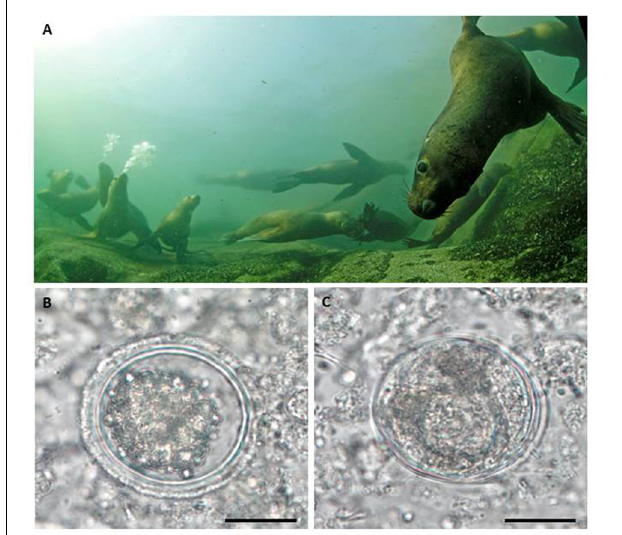
FIGURE 1 | (A) Scat collection of South American sea lions ( Otaria flavescens ) ( n = 28) was performed by scuba dives under water in front of sea lion colony of Comau Fjord, Patagonia, Chile, without disturbance of animals. (B) Illustration of an Anisakis spp. egg and (C) a Balandium spp. cyst (scale bar 20 µ m) identified in sea lion fecal